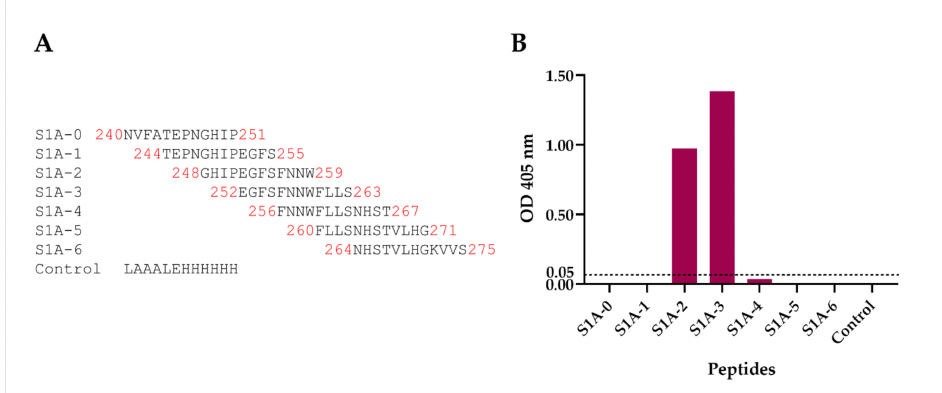
Figure 7. Overlapped peptides of PEDV spike protein bound by the mAbA3 as tested by peptide- binding ELISA. Biotin-labeled 12-mer overlapped peptides encompass PEDV spike protein (amino acid residues 240–275th) were used in the indirect ELISA for testing mAbA3 binding. ( A ) List and amino acid sequences of the 8 overlapped peptides of the PEDV spike protein. ( B ) OD 405 nm of mAbA3 that bound to individual overlapped S1 peptides and control peptide. The mAbA3 bound to peptides S1A-2 (248GHIPEGFSFNNW259) and S1A-3 (252EGFSFNNWFLLS263) and yielded high ELISA